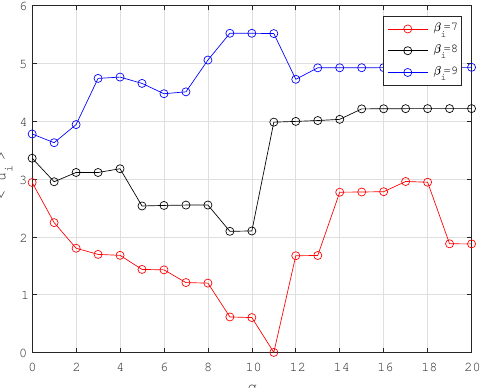
Figure 7. Dependence of the average population size < u i > on the coupling strength q obtained for different values of the Allee threshold as shown by different colours: β = 7, β = 8 and β = 9 for red, black and blue,